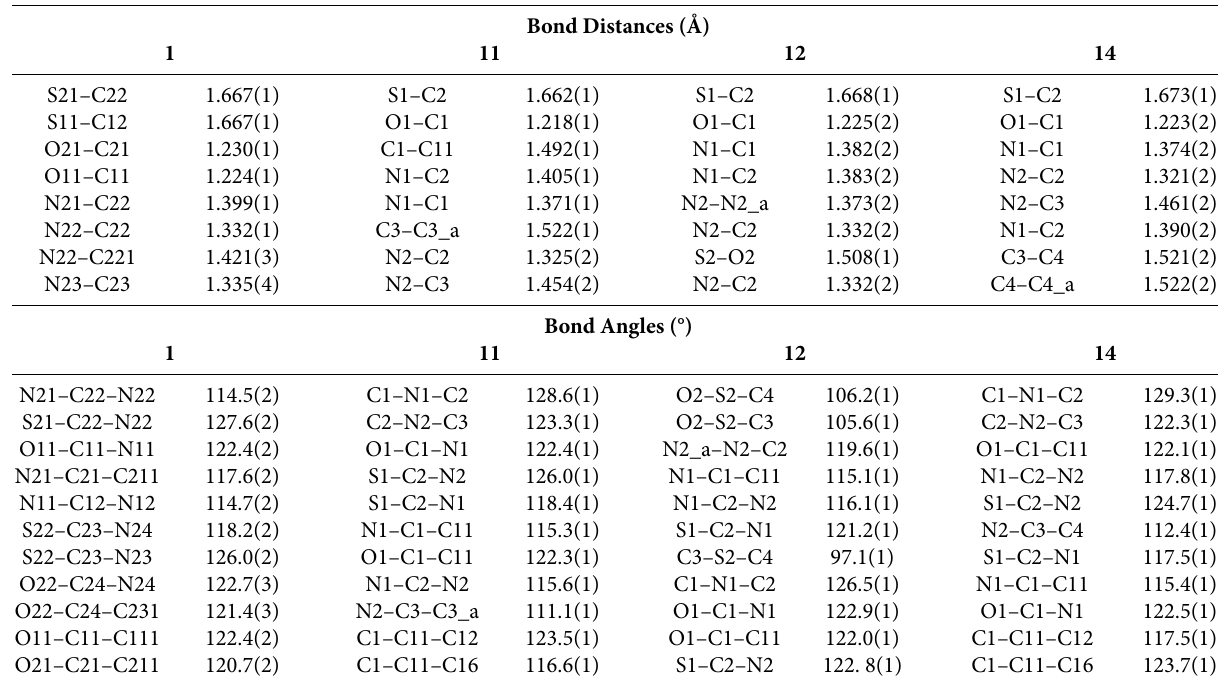
Bond Distances (Å)